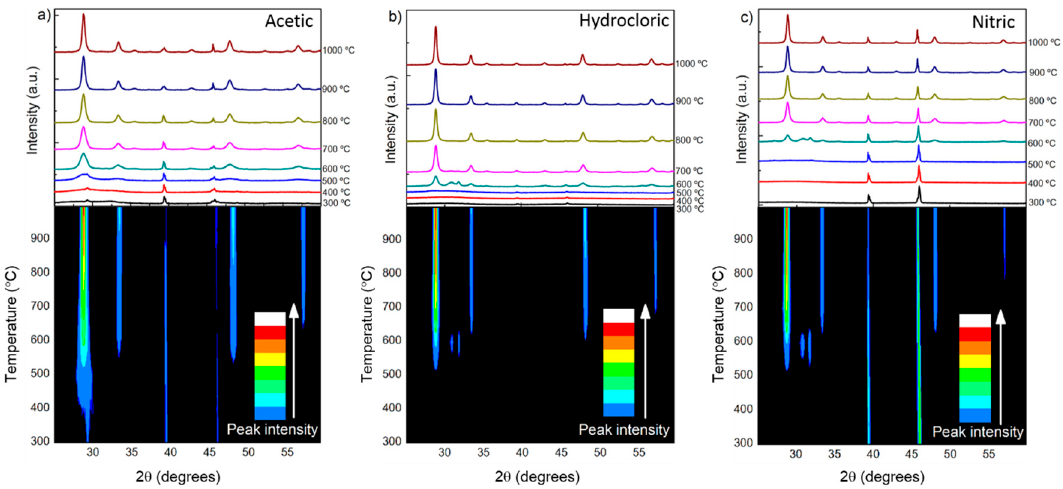
Figure 3. In situ XRD diffractograms as a function of temperature (on top) and the respective contour plot (on bottom) of Yb/Eu doped Y 2 O 3 nanostructures after microwave synthesis, when using ( a ) acetic, ( b ) hydrochloric and ( c ) nitric acids.